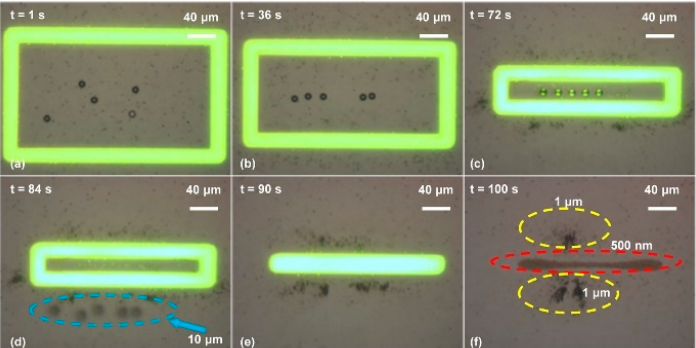
Figure 6. Simultaneous separation of polystyrene beads with diameters of 500 nm, 1 µ m, and 10 µ m. ( a ) When the OEK chip was illuminated by the optical rectangle pattern under the action of an external AC bias potential, both the 500 nm and 1 µ m polystyrene beads were attracted to the illuminated area. By contrast, the 10 µ m ones were pushed away from the optical ring; ( b ) as the optical rectangle size decreased, the 10 µ m polystyrene beads moved towards the central area of the optical rectangle and those with the other two diameters still resided within the optical ring; ( c ) when the gap formed by the long sides of the rectangle was around 10 µ m, the 10 µ m polystyrene beads were aligned; ( d ) the 10 µ m polystyrene beads were separated as the rectangle size further decreased; ( e ) the rectangle was decreased to a line pattern; ( f ) the 500 nm and 1 µ m polystyrene beads were finally located at di ff erent positions of the OEK chip (reproduced from Ref. [42]).